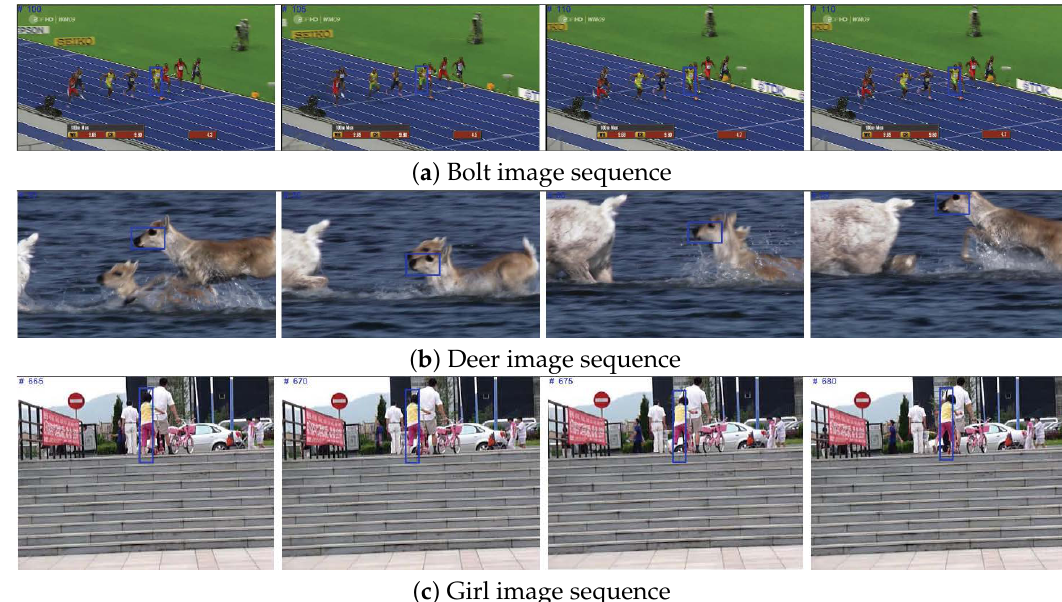
Figure 7. Tracking during background clutter